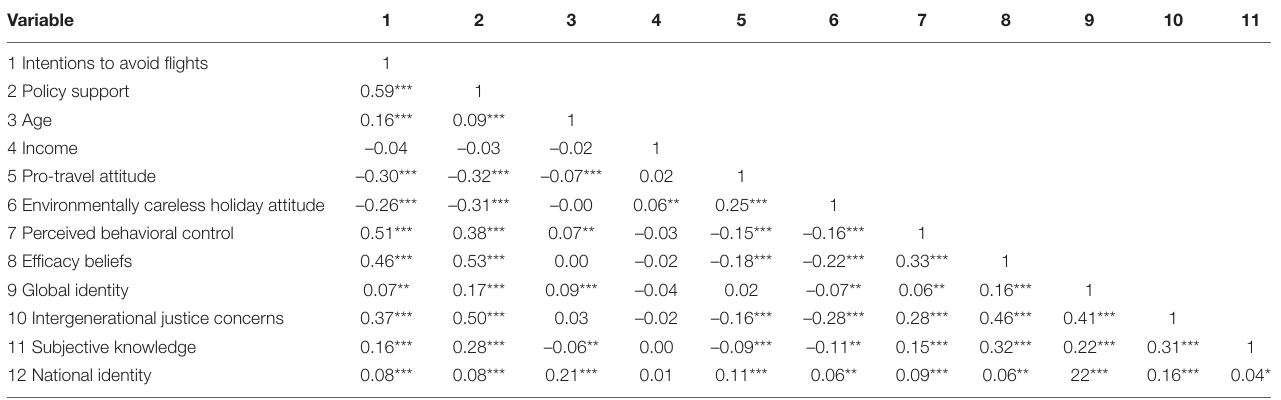
TABLE 5 | Bivariate correlations of the predictor variables and outcome measures addressed in this study. Variable